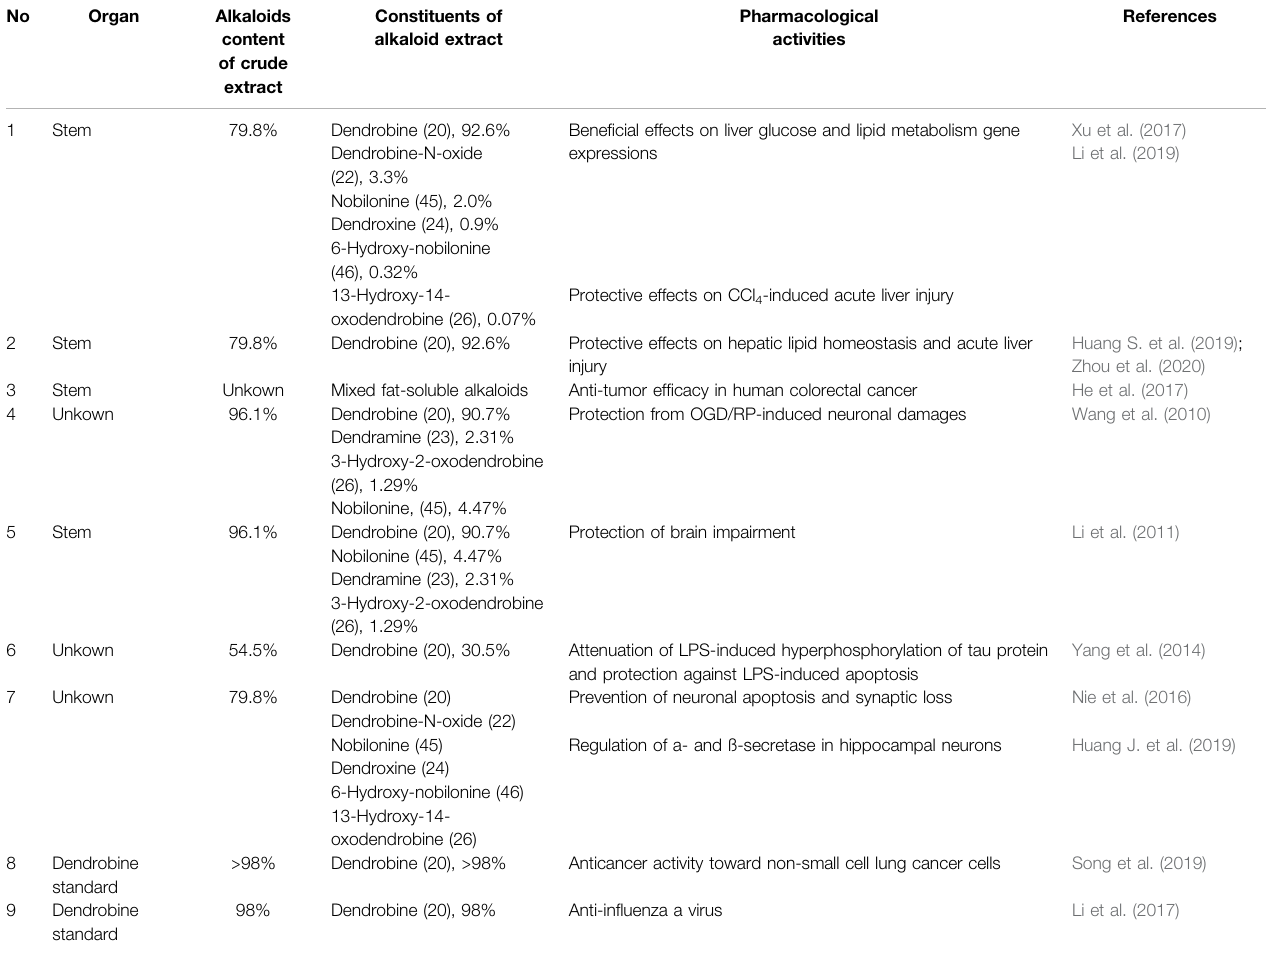
TABLE 2 | Summary of the pharmacological of alkaloids isolated from Dendrobium nobile